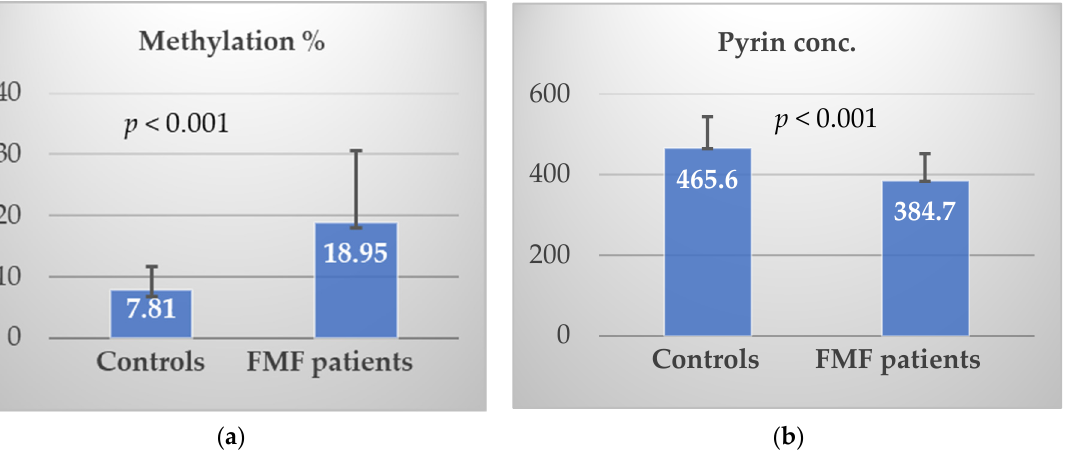
Figure 1. ( a ) Distribution of the MEFV exon 2 methylation% among FMF patients and controls; ( b ) distribution of the pyrin level among FMF patients and